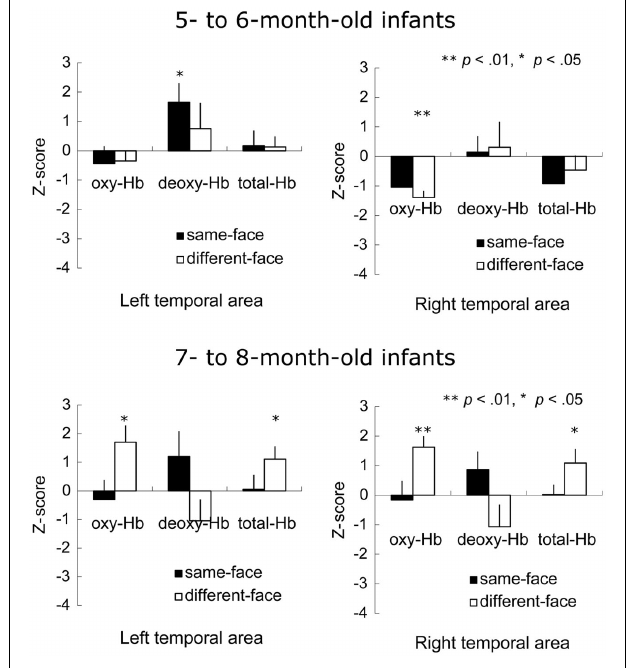
FIGURE 7 | Mean Z -score from 3 to 7s after stimulus onset in the bilateral temporal area in Experiment 2. The vertical line in the graphs represents 1 SE. At 5–6months of age, the concentration of deoxy-Hb significantly increased during the same-face condition under the different viewpoint presentation only in the left temporal area. Furthermore, the decrease in oxy-Hb concentration was significant in the right temporal area while infants looked at the different-face condition. At 7–8months, in the different-face condition (white bar), the concentration of oxy-Hb and total-Hb in both the right and left temporal areas increased significantly compared to the chance level of 0 ( ∗∗ p < 0.01, ∗ p <